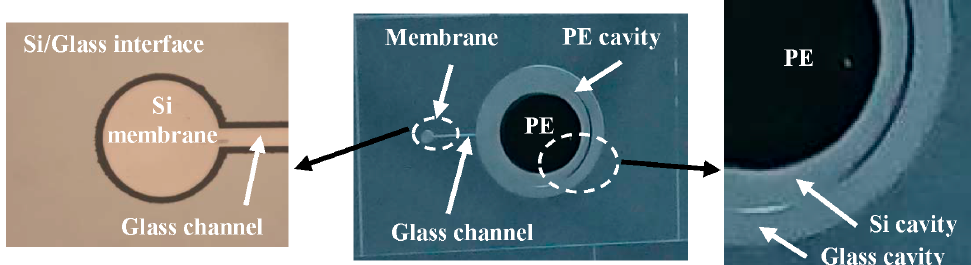
Figure 5. Bottom views of fabricated